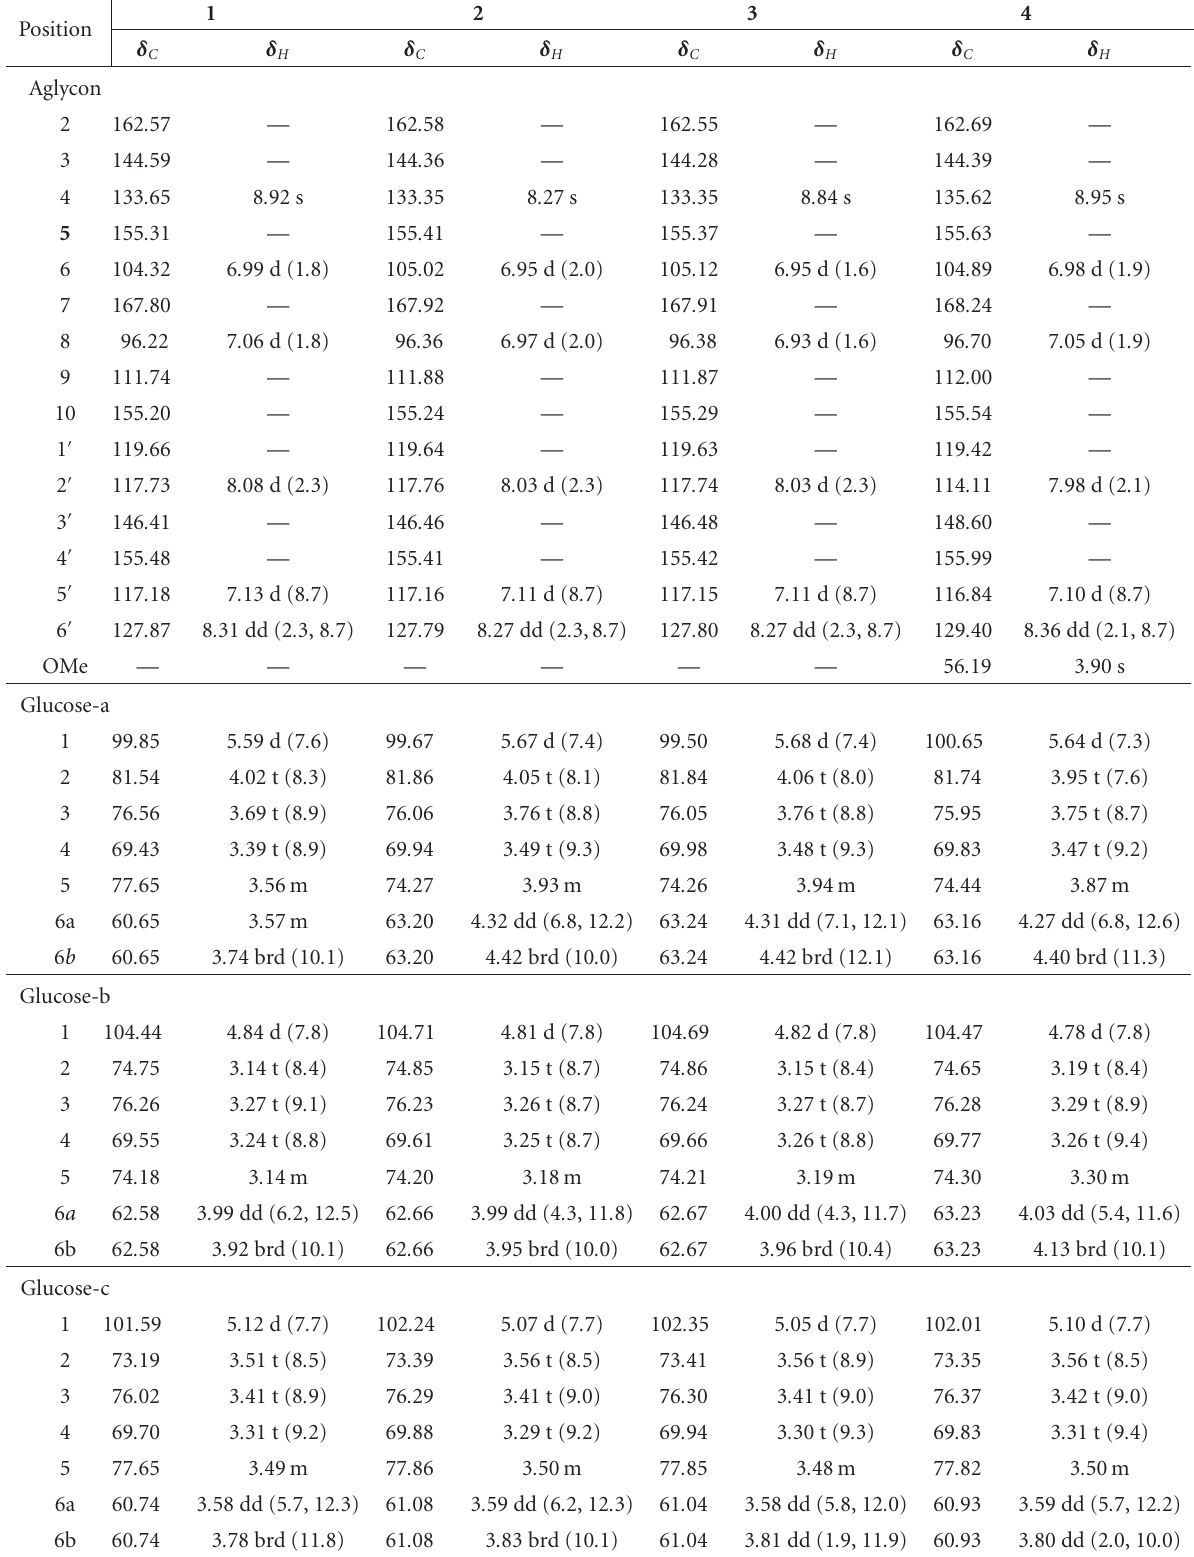
Table 1. NMR chemical shifts purple-fleshed sweet potato callus anthocyanins 1 , 2 , 3 , and 4 from tetramethylsilane in DMSO-